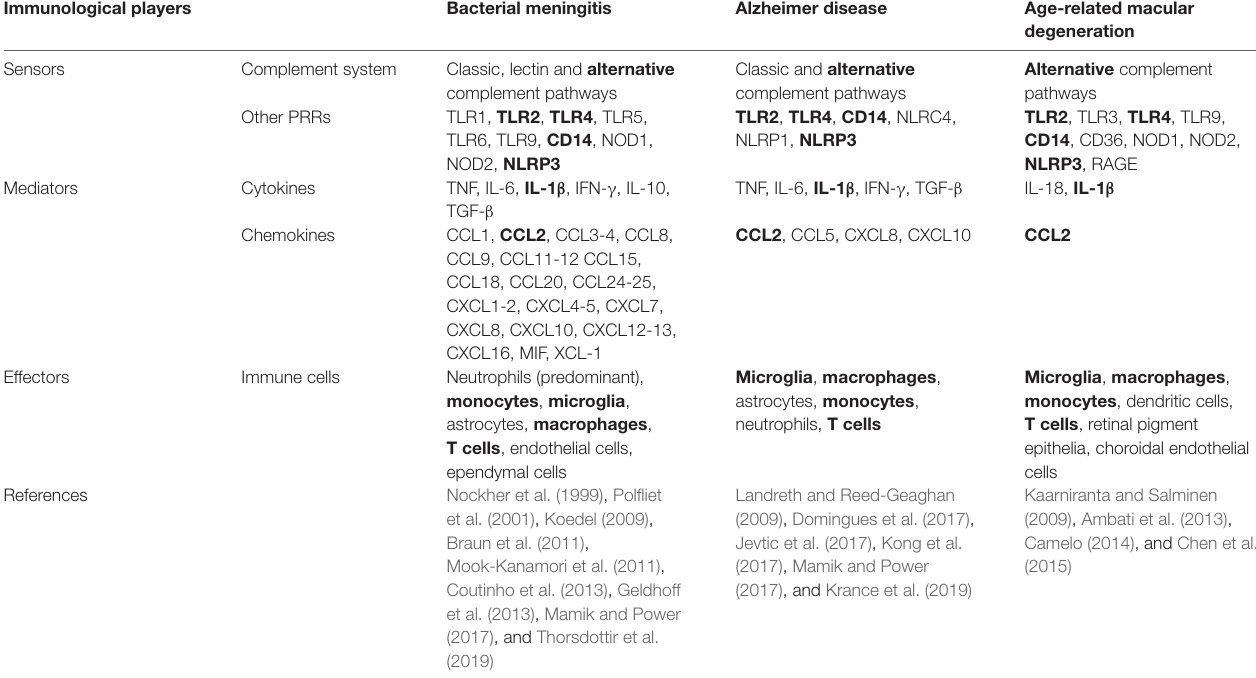
TABLE 1 | Key players in innate immunity that underlie the pathogenesis of bacterial meningitis, and potentially Alzheimer disease and age-related macular